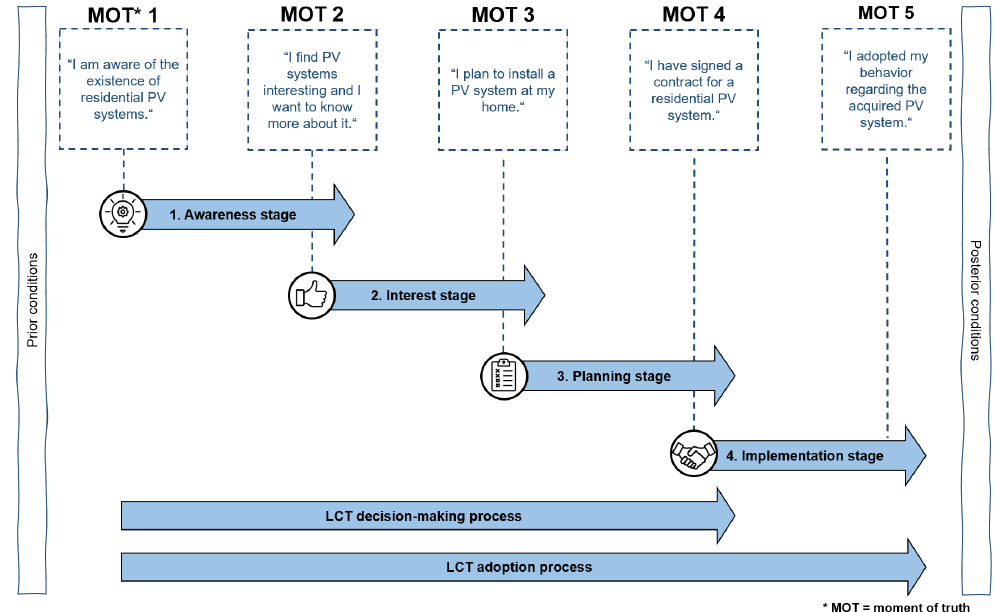
Figure 2. Process stages of residential low-carbon technology decision-making with particular attention to the behavioral transitions (MOT = moment of truth). According to the objective of this paper, the three stages of the decision-making process (awareness, interest, planning) are in focus (own